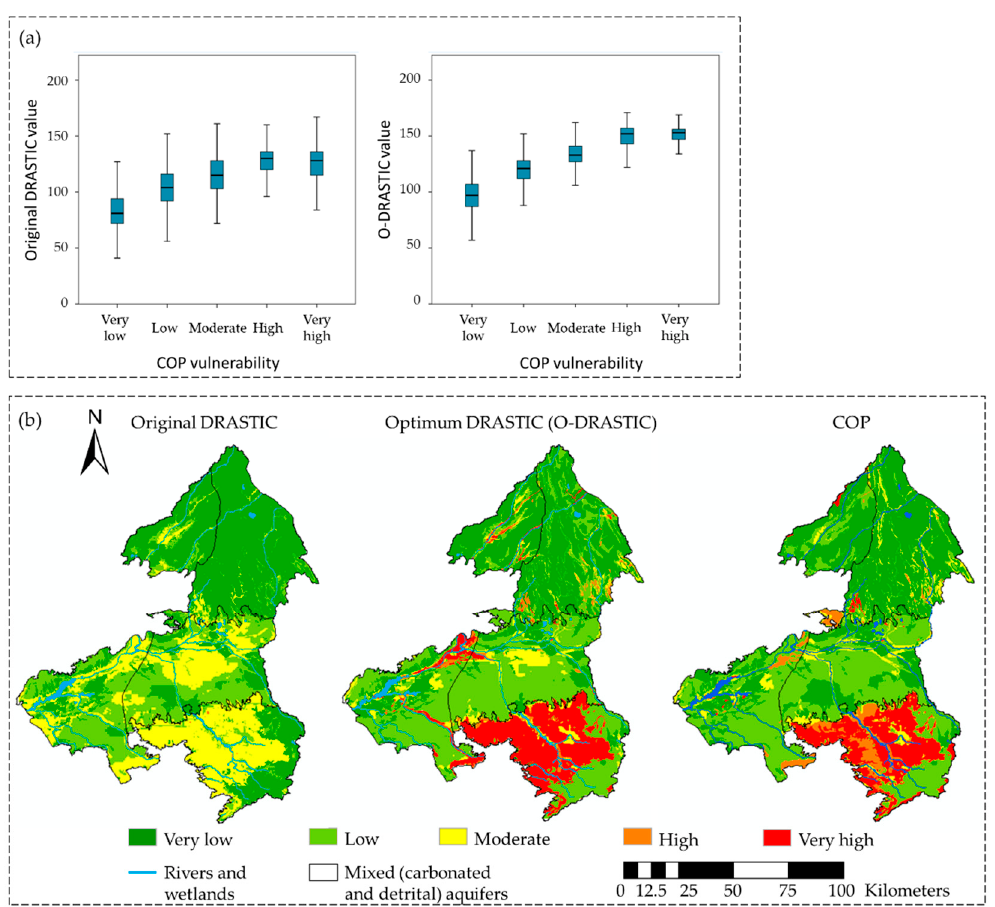
Figure 7. Distribution of vulnerability values of original DRASTIC and O-DRASTIC within vulnerability classes in COP ( a ); vulnerability maps for original DRASTIC, O-DRASTIC and COP ( b ).